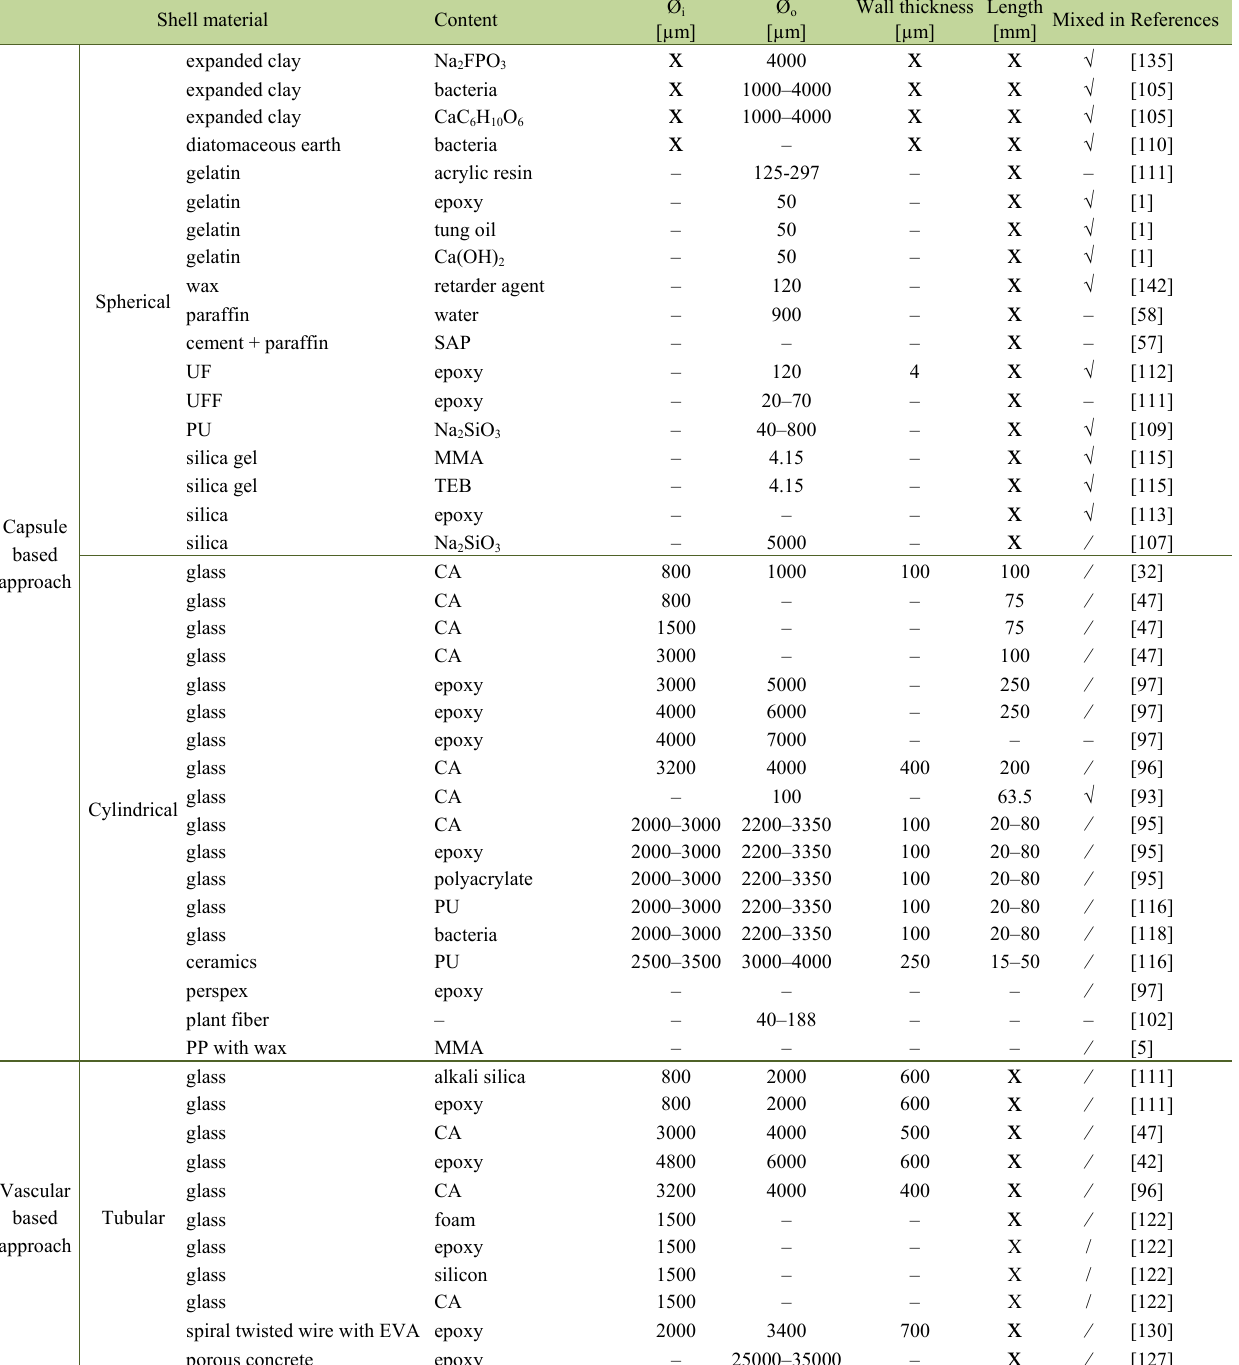
Table 2. Overview of the encapsulation techniques which have been reported in the literature (“–” means “not reported”, “x” means “not applicable”, “√” means “yes” and “/” means